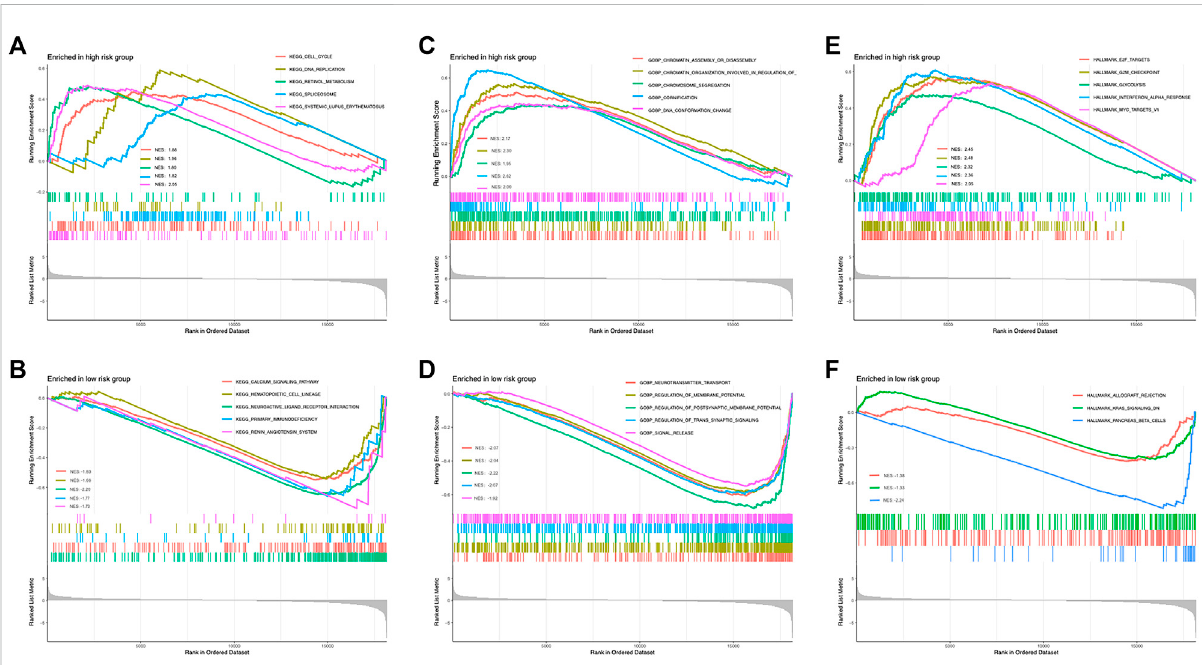
FIGURE 5 Enrichment of distinguished genes, pathways, and biological processes between low- and high-risk subgroups. (A) Top enriched KEGG signaling pathways in high risk group. (B) Top enriched KEGG signaling pathways in low risk group. (C) Top enrichedGO biological processes in